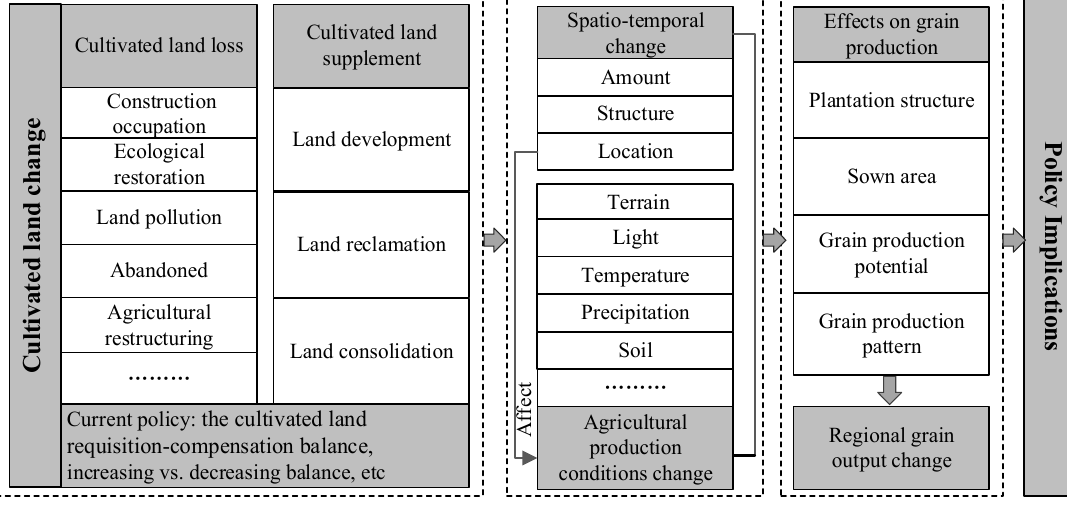
Figure 2. Influence mechanism of cultivated land change on grain production.